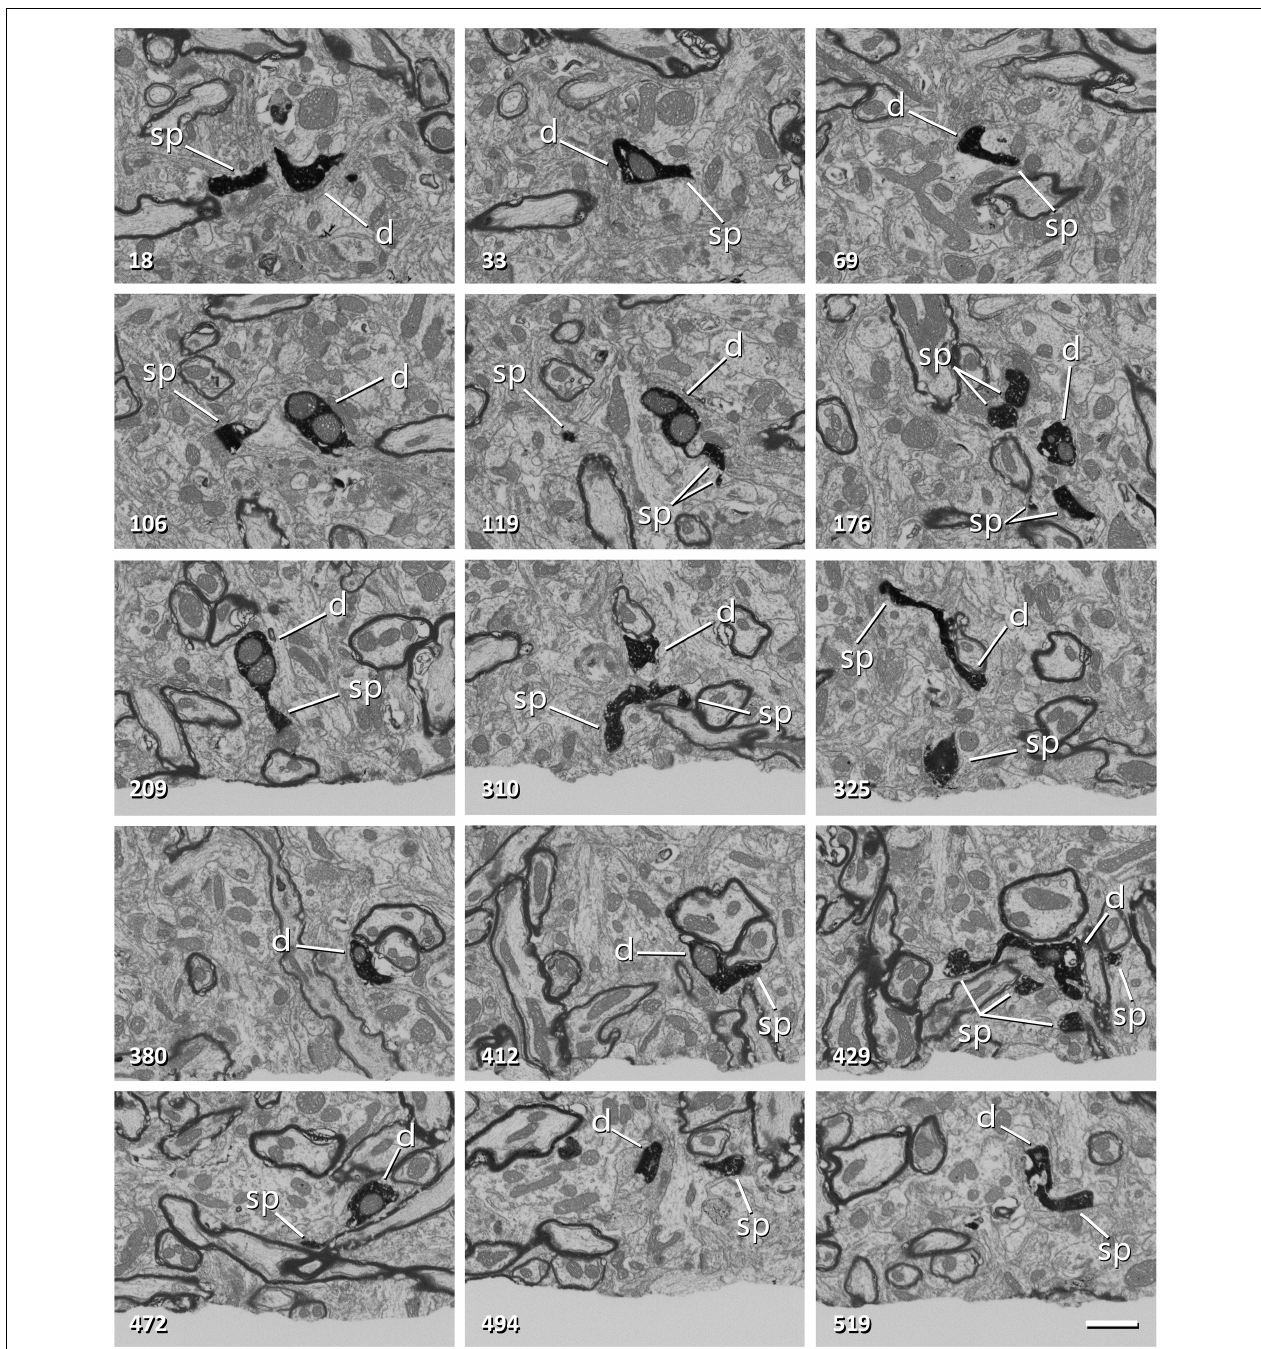
FIGURE 3 | Non-consecutive images of a labeled dendrite from a series obtained with FIB-SEM. The number in the bottom-left corner indicates the position of each image in the series. The dendritic shaft (d) and dendritic spines (sp) are filled with a dark electron-dense precipitate. Note that frame 106 corresponds to Figure 2G . Scale bar, 1 µ m. See also Supplementary Video 1